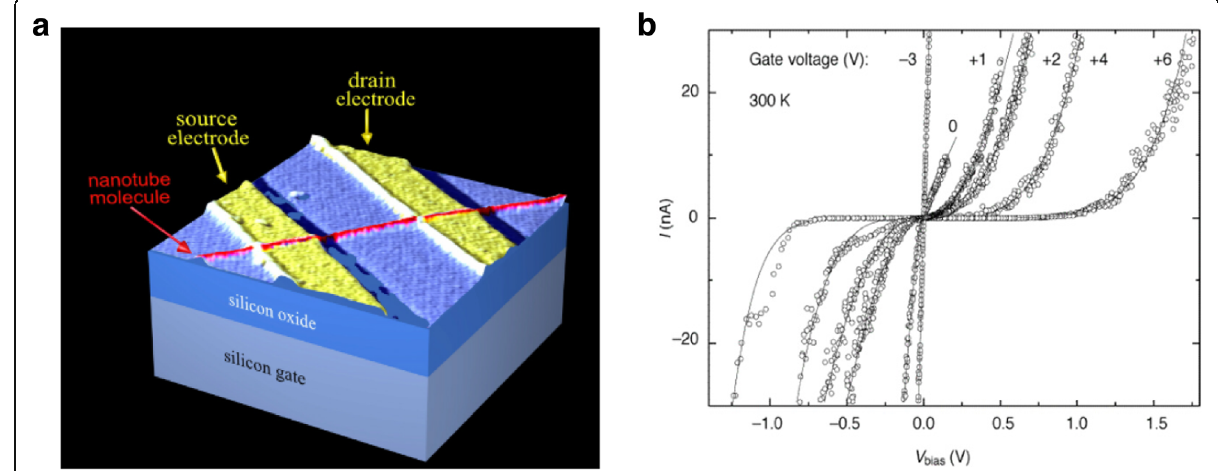
Fig. 3 a Schematic illustration of the initial CNTFET demonstration. The transistor could be turned on by applying a gate voltage to the silicon substrate (back gate) that induces carriers into the nanotube channel bridging the source and drain electrodes. Adapted from [45]. b I - V characteristics of CNTFET showing switching between ohmic and nonlinear behaviors at different gate voltages. Adapted from